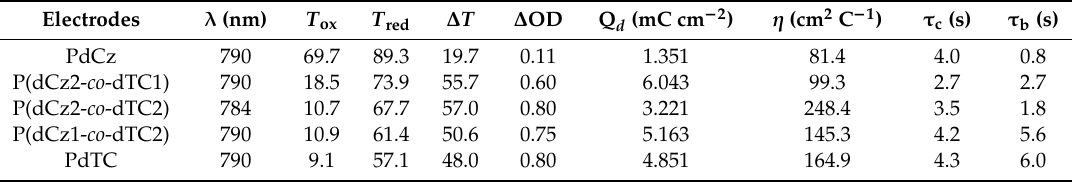
Table 3. Optical and electrochemical properties investigated at the selected applied wavelength for the electrodes.